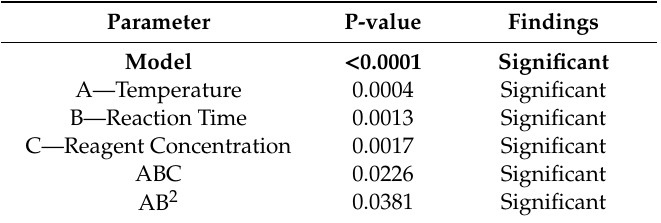
Table 8. Analysis of variance (ANOVA) for the experimental variables.